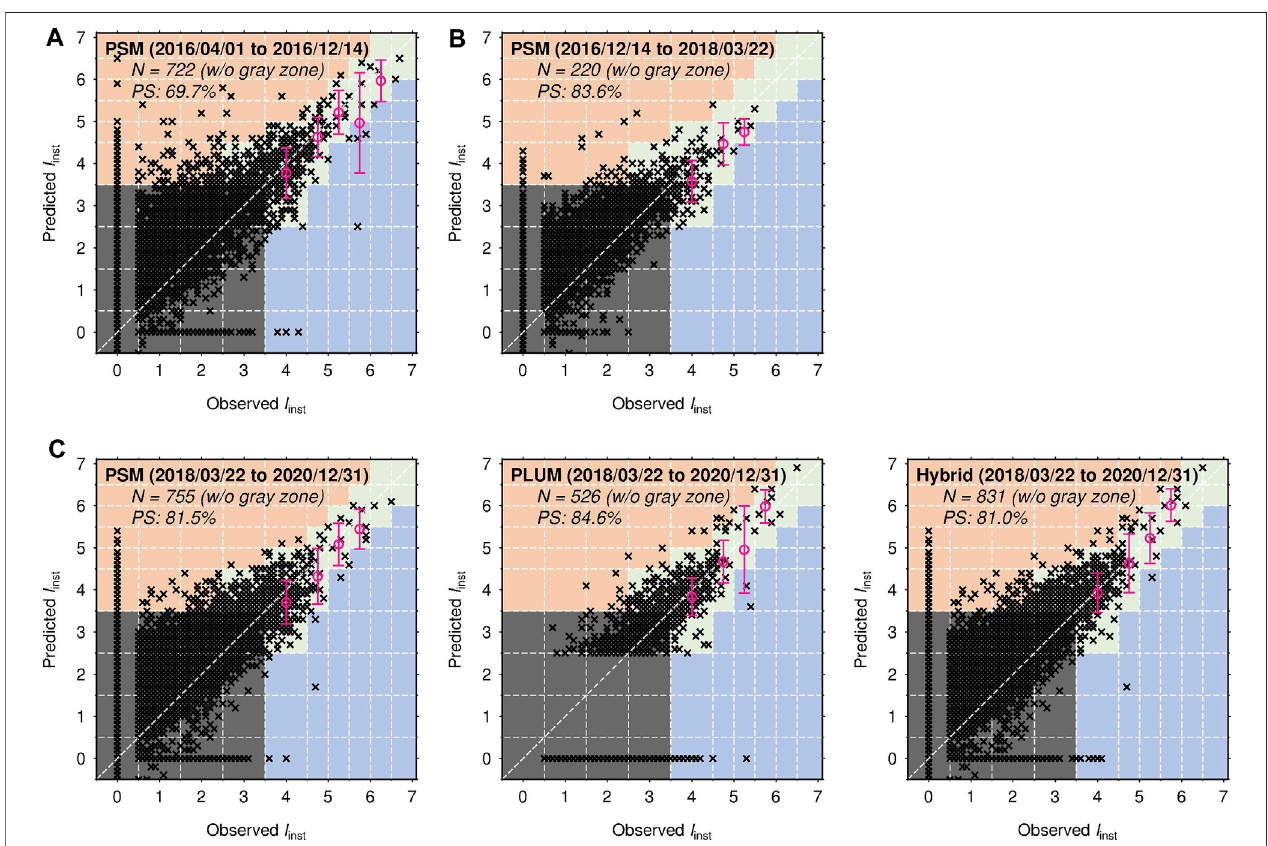
FIGURE 3 | Comparisons of observed and predicted intensities using the maximum ground motion prediction results for the three periods: (A) April 1, 2016 to December 14, 2016 (the start date for the IPF operation), (B) December 14, 2016 to March 22, 2018 (the start date for the PLUM operation), and (C) March 22, 2018 to December 31, 2020. Intensities were plotted on an area-by-area basis; that is, each intensity was obtained by taking the maximum among those at all sites in a sub- prefecturalarea. Circlesand bars inmagenta indicate themeanand standarddeviationofpredicted intensities foreach observed I JMA (datapoints withapredicted intensity equal to 0 were eliminated for the calculation). Green zone is one in which prediction errors were within one I JMA unit (we assumed that those errors were acceptable). Orange and blue zones are ones in which ground motions were overpredicted and underpredicted with intensity errors of two or more units, respectively. Data points with predicted and observed I JMA ≤ 3 (i.e., I inst < 3.5) are in the gray zone. The prediction score (PS) was calculated, de fi ned as the ratio of areas whose intensitypredictionerrorwaswithinone